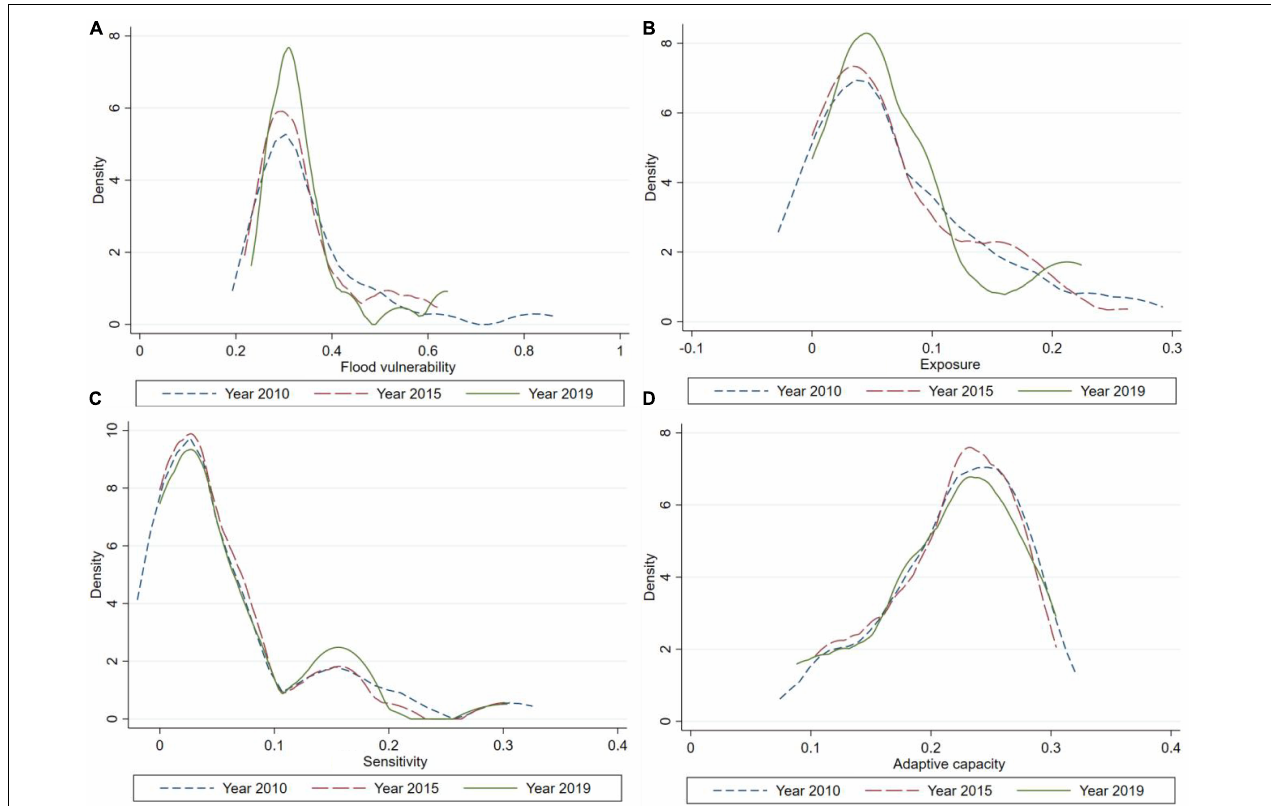
FIGURE 3 | Dynamic evolution distribution of vulnerability to floods and its decomposition terms in China’s inland fisheries. (A) Flood vulnerability. (B) Exposure. (C) Sensitivity. (D) Adaptive capacity.